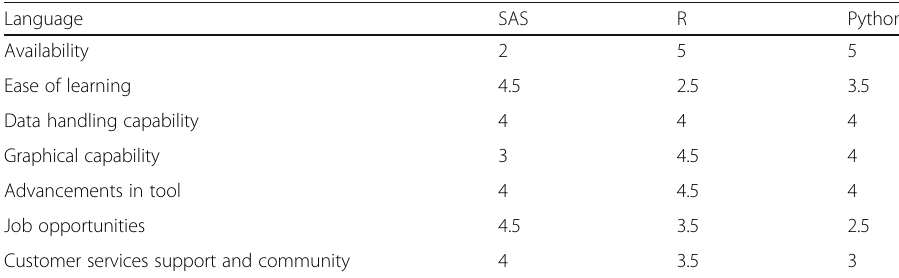
Table 1 Comparisons between R, SAS and Python (5 being the best)